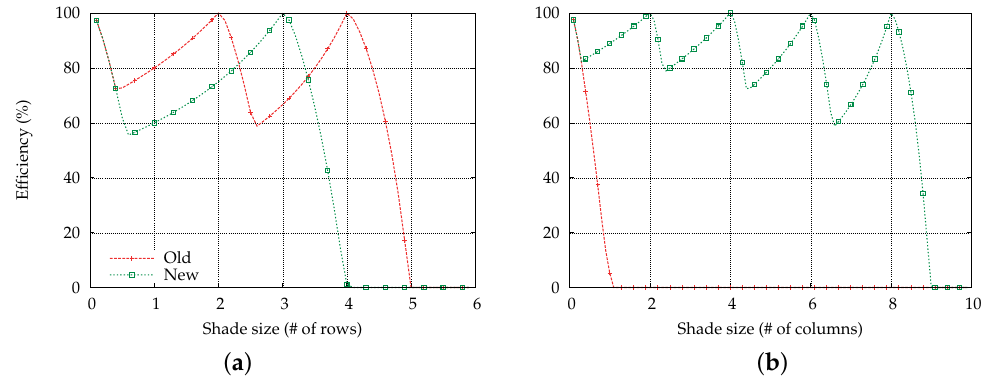
Figure 12. Efficiency comparison between the old and new panel setup under different shading scenarios: ( a ) horizontal shade and ( b ) vertical shade. Values in between the natural numbers on the x axis denote the shading intensity of the next row or column.